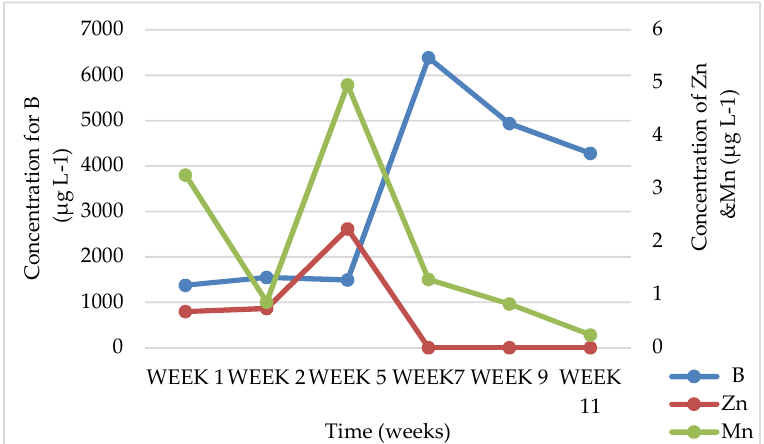
Figure 8. Chemical-element concentrations in leachates obtained from CFA (Coal-fly-ash) pots growing S. oleracea L. for essential elements B, Zn, and Mn.